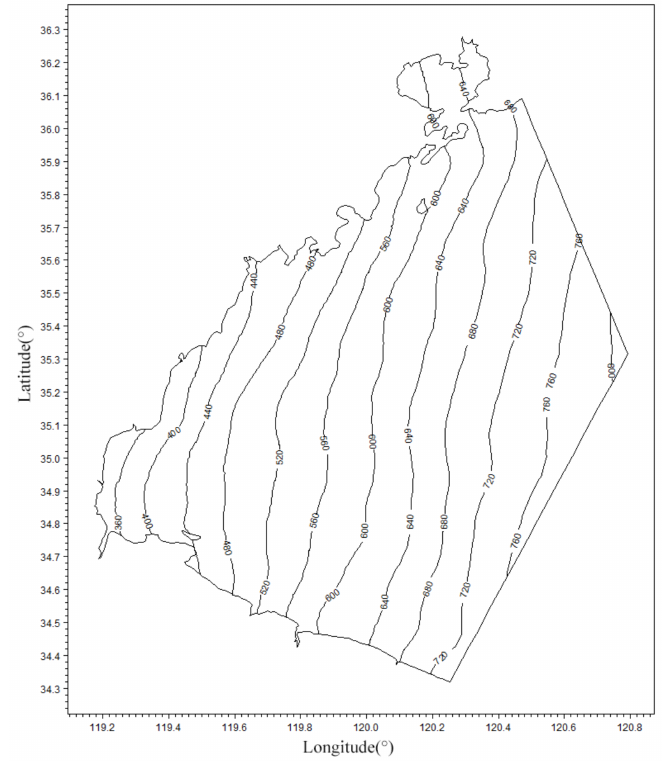
Figure 5. Average sea surface height model (unit: cm).